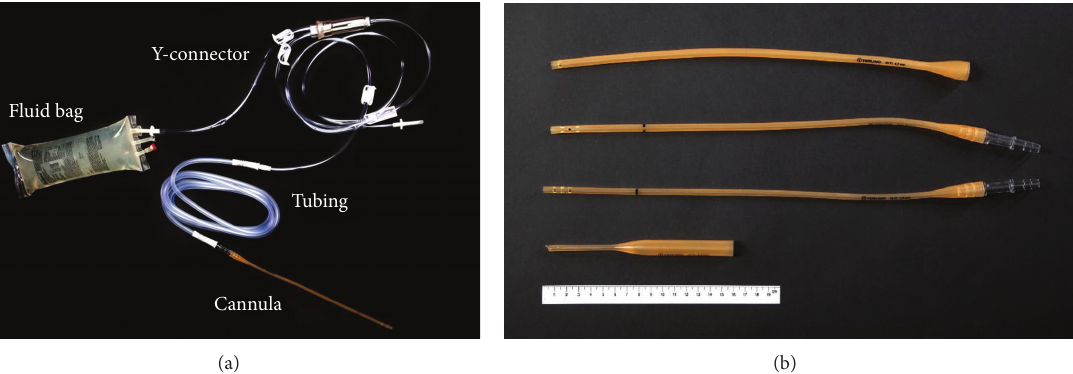
Figure 2: (a) Photograph showing a UW bag with Y-connector, Flexi-Rib tubing, and an 18Fr cannula. (b) Cannulas used in the study (from top to bottom, 20, 18, 16, and 14Fr, resp.). A 20 cm ruler is present for scale.